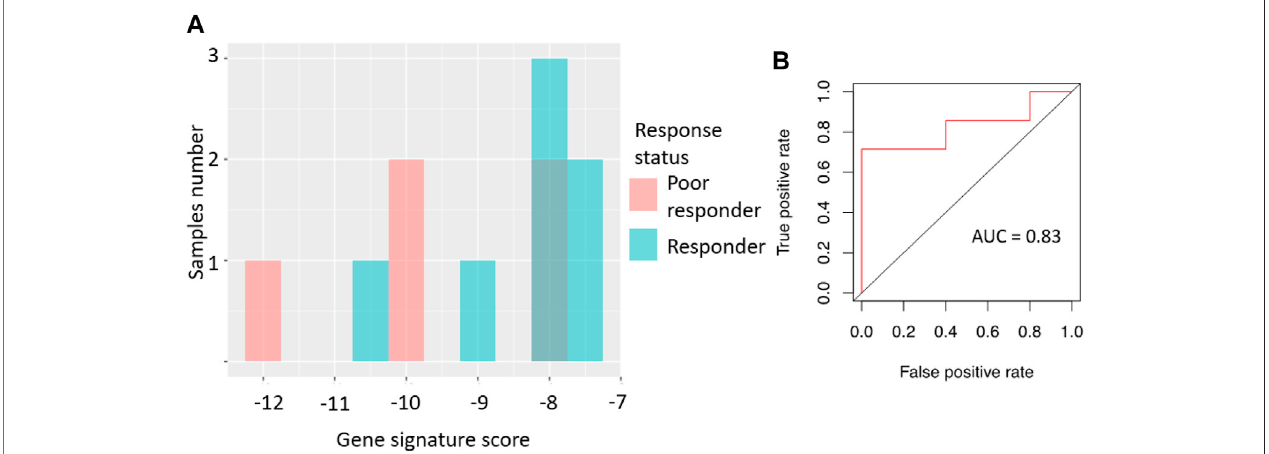
FIGURE4| Performanceofsorafenibresponse genesignatureinmicroarray-pro fi ledRCCset. (A) Distributionofgenesignaturescorein22RCC samplespro fi led by expression microarrays. (B) ROC (receiver-operator characteristic) curve for prediction of response status by gene signature score in 22 RCC samples pro fi led by expression microarrays. In vitro validation of sorafenib response gene signature.